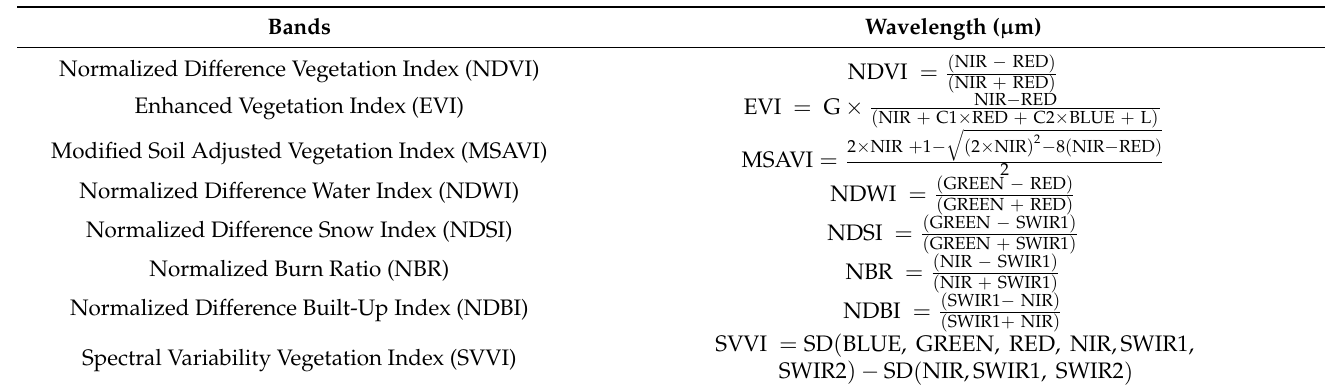
Table 2. Extracted spectral indices from Landsat 8